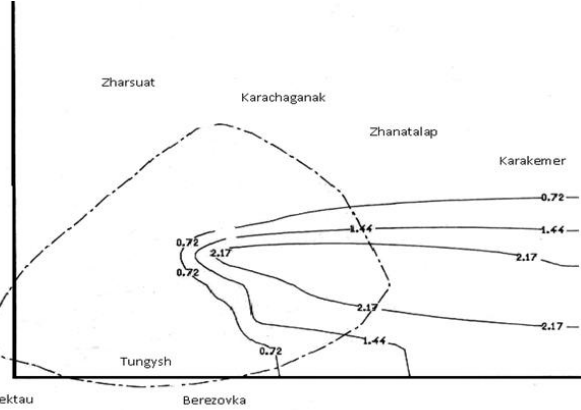
Figure 2: Isolines of the CO 2 concentration in the maximum permis- sible concentration shares at a height of 10 m . Max CO 2 − 2, 89